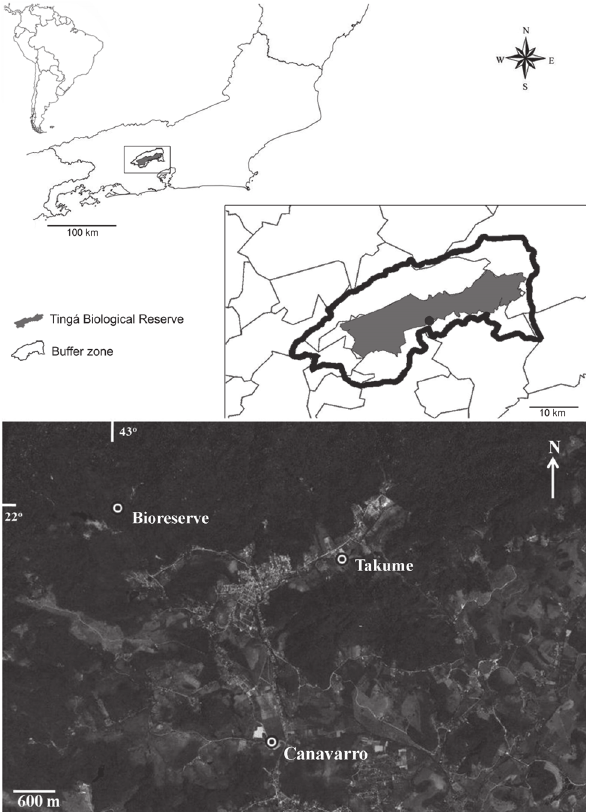
Figure 1. Location of the buffer zone and Tinguá Biological Re- serve, state of Rio de Janeiro, with satellite image (Google Earth: April 22, 2011) indication of the sampling